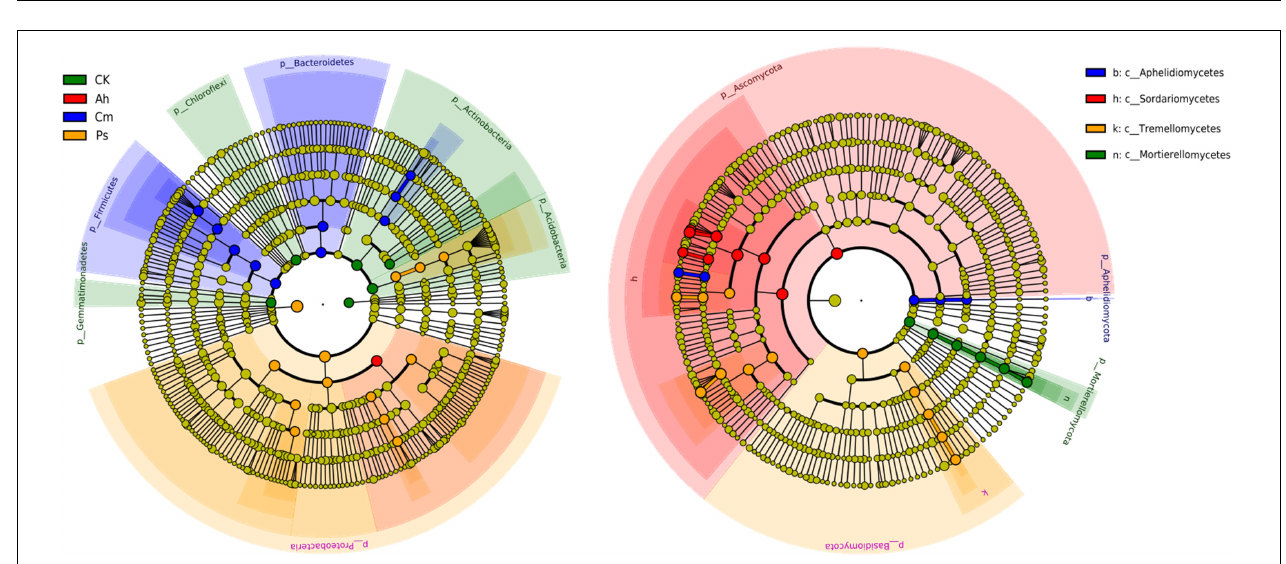
FIGURE 3 | LEfSe analysis of bacterial community of the CK (no litter addition) and single litter addition treatments. A cladogram showing taxonomic representation of statistical and biological differences among groups. Taxa and nodes highlighted in different colors were significantly elevated in CK, Ah, Cm, and Ps litter addition, respectively ( p < 0.01). Nodes remaining yellow indicate taxa that were not significantly different. The diameter of the circle is proportional to